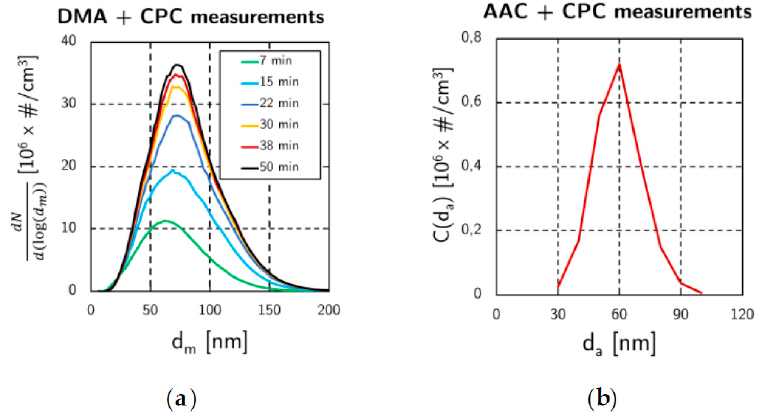
Figure 2. Size distribution functions. ( a ) Mobility diameter measured by the DMA (for different times after the mini-CAS T start-up); ( b ) Aero dynamic diameter measured by the